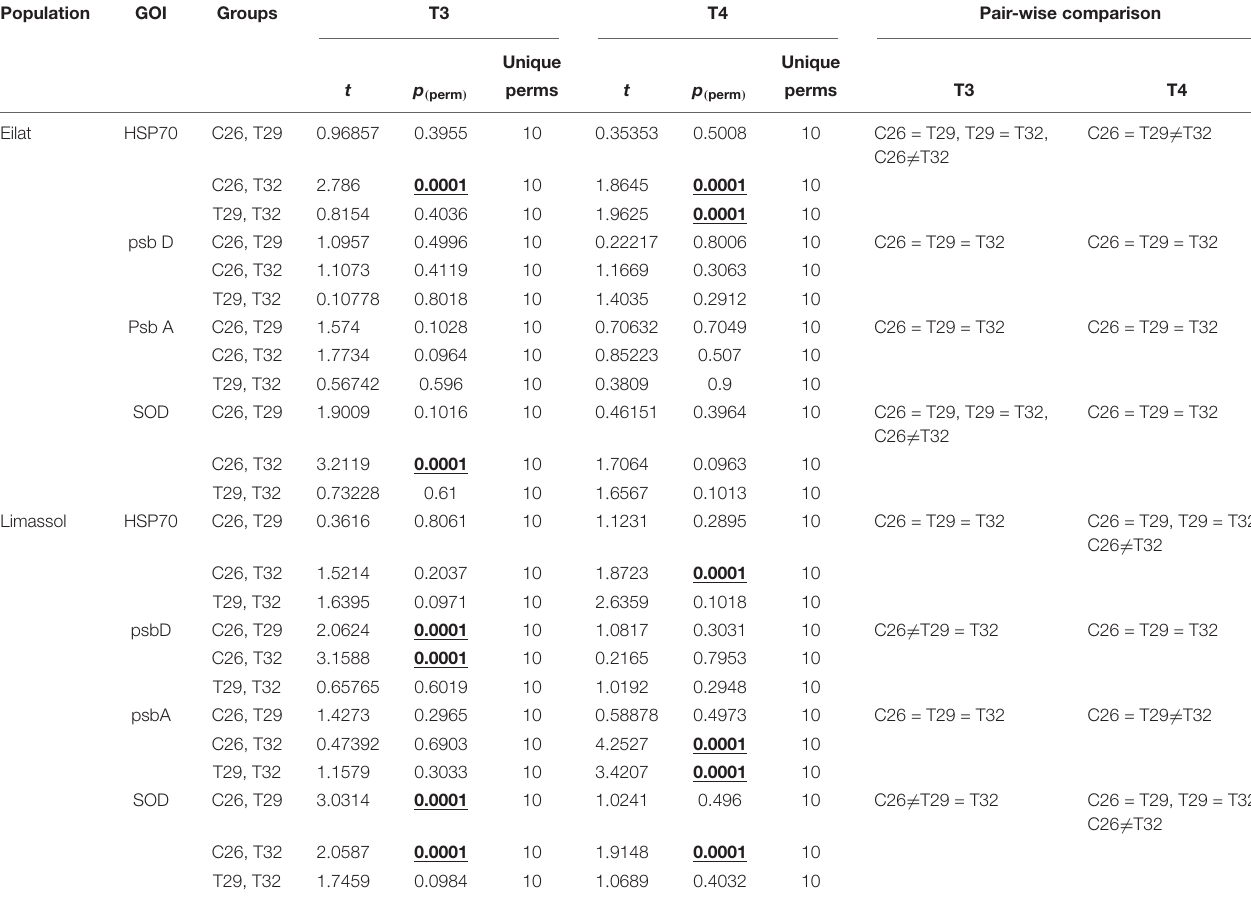
TABLE 3 | Pair-wise comparison results on (cid:49) Ct data of genes of interests (GOIs). Population GOI Groups T3 T4 Pair-wise comparison